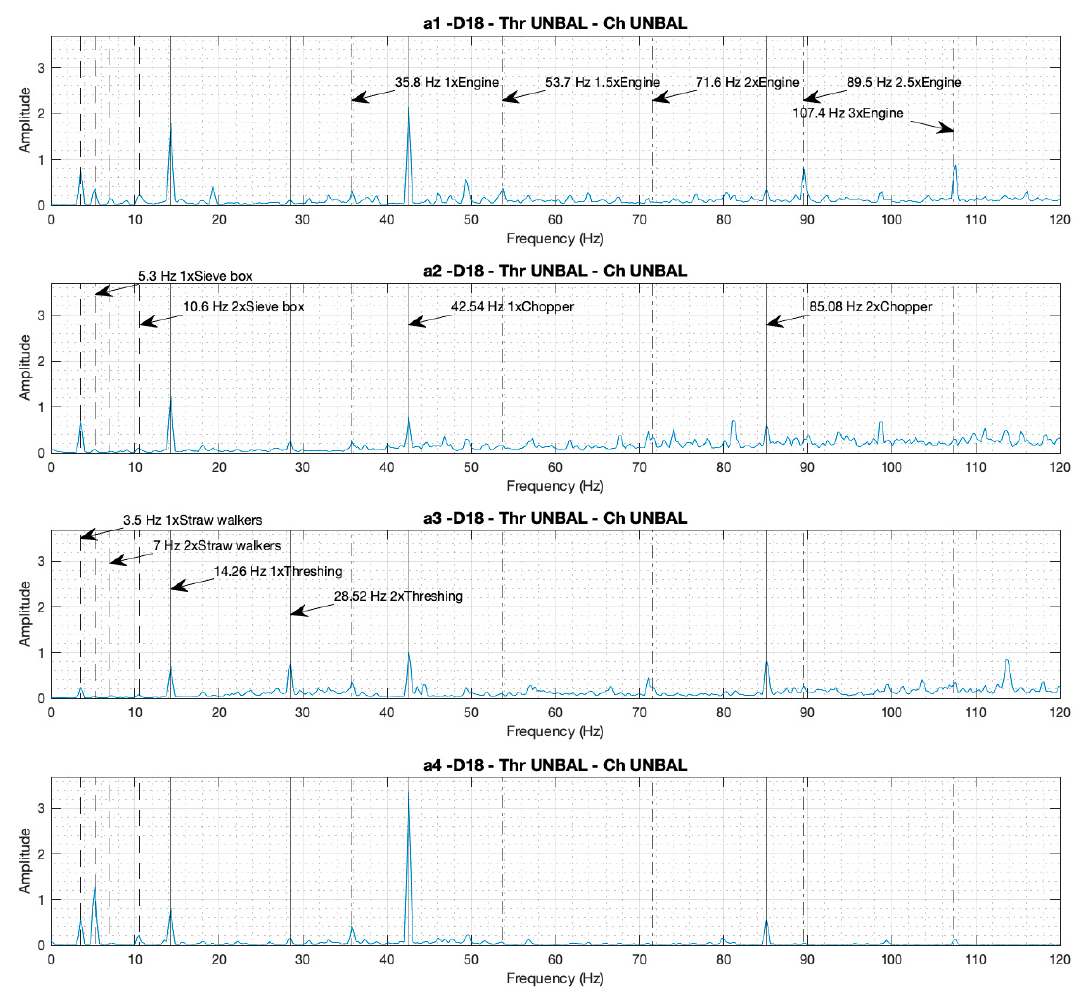
Figure 3. Individual spectra from the four accelerometers (a1–4), with the thresher and the chopper both engaged and unbalanced, with the motor at maximum rotational speed (Case D18).